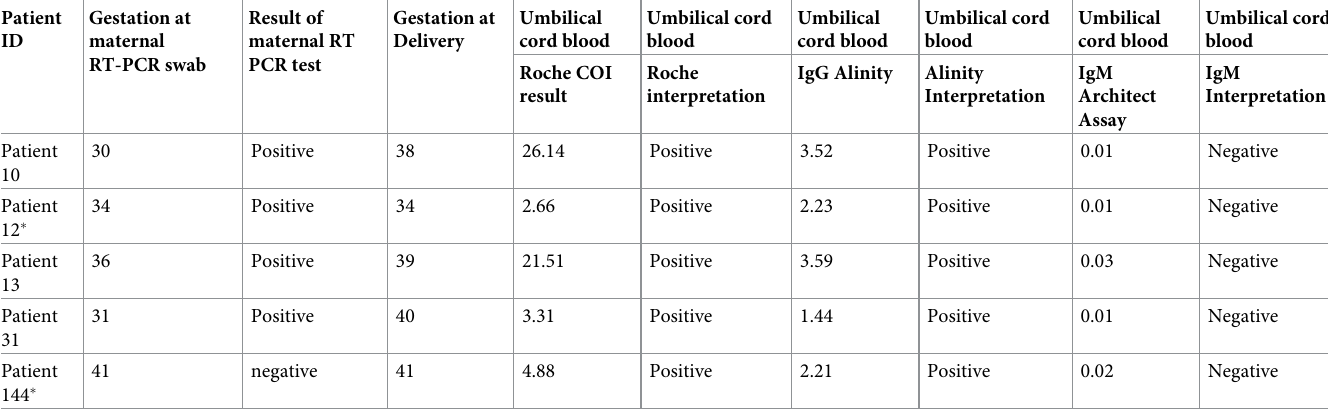
Table 2. Umbilical cord bloods samples positive for